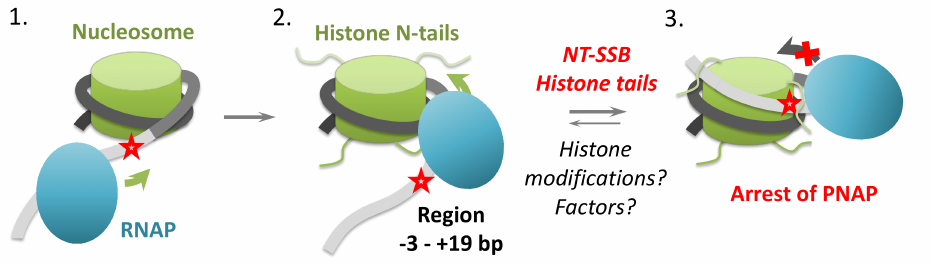
Figure 7. Proposed roles of NT-SSBs and histone N-terminal tails during transcription of the early region of nucleosomal DNA containing a damage. Transcription of the linker and early nucleosomal DNA (intermediate 1) induces transient DNA uncoiling from the histone octamer (intermediate 2) and formation of an unstable intranucleosomal i-loops when the active center of RNA polymerase traverses the − 3 to +19 bp DNA region (intermediate 3); the i-loops often incorporate linker DNA. I- loops are stabilized by NT-SSBs (indicated by red stars) and by the histone tails. Histone modifications of the tails and factors interacting with core histones or RNA polymerase could affect the efficiency of loop